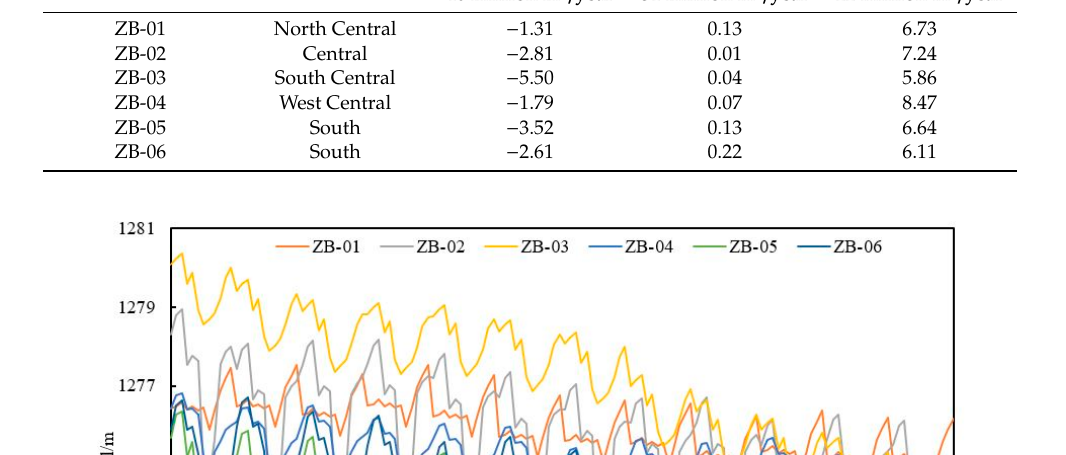
Monitoring Well